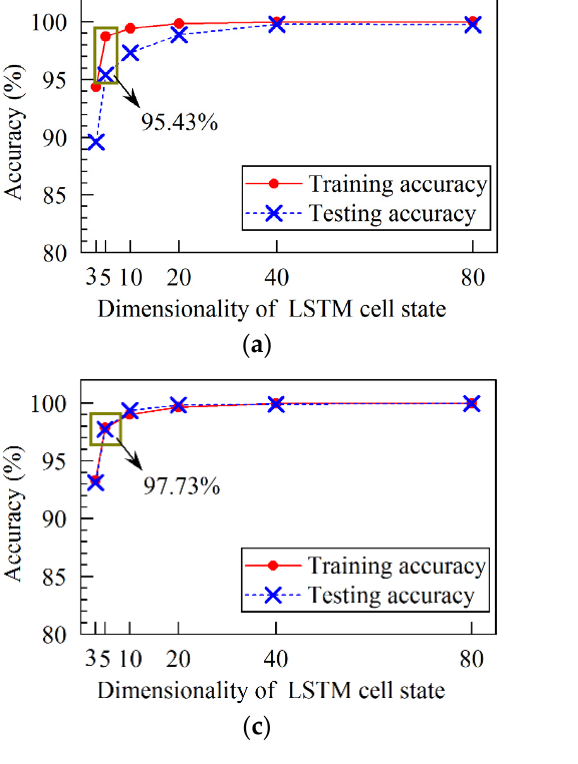
Figure 15. Training and testing accuracies of the third network structure. ( a ) Mode 2_a. ( b ) Mode 2_b. ( c ) Mode 2_c. ( d ) Mode 2_d. The dark yellow circles mark the accuracies that are more than 95% with the lowest number of hidden layer elements.